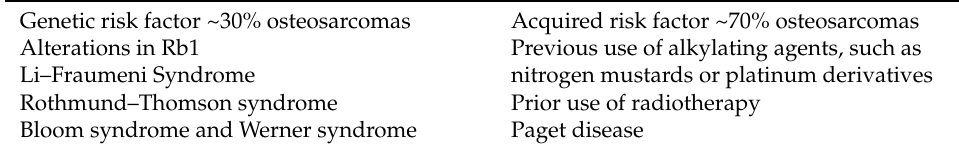
Table 2. Main risk factors in